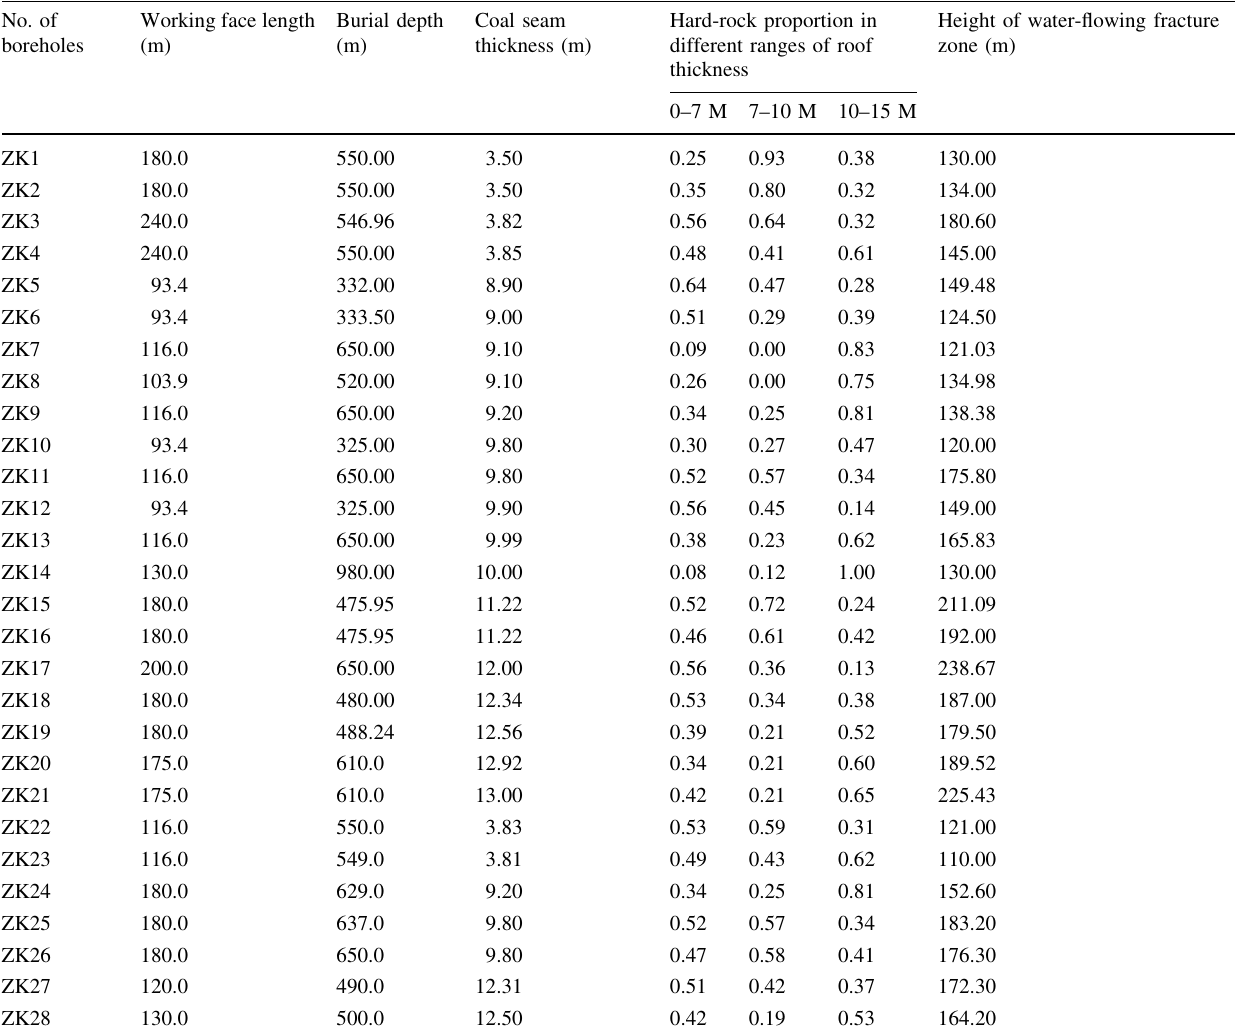
Table 1 Measured height of the water-flowing fracture zone and its main control factors No. of Working face length boreholes